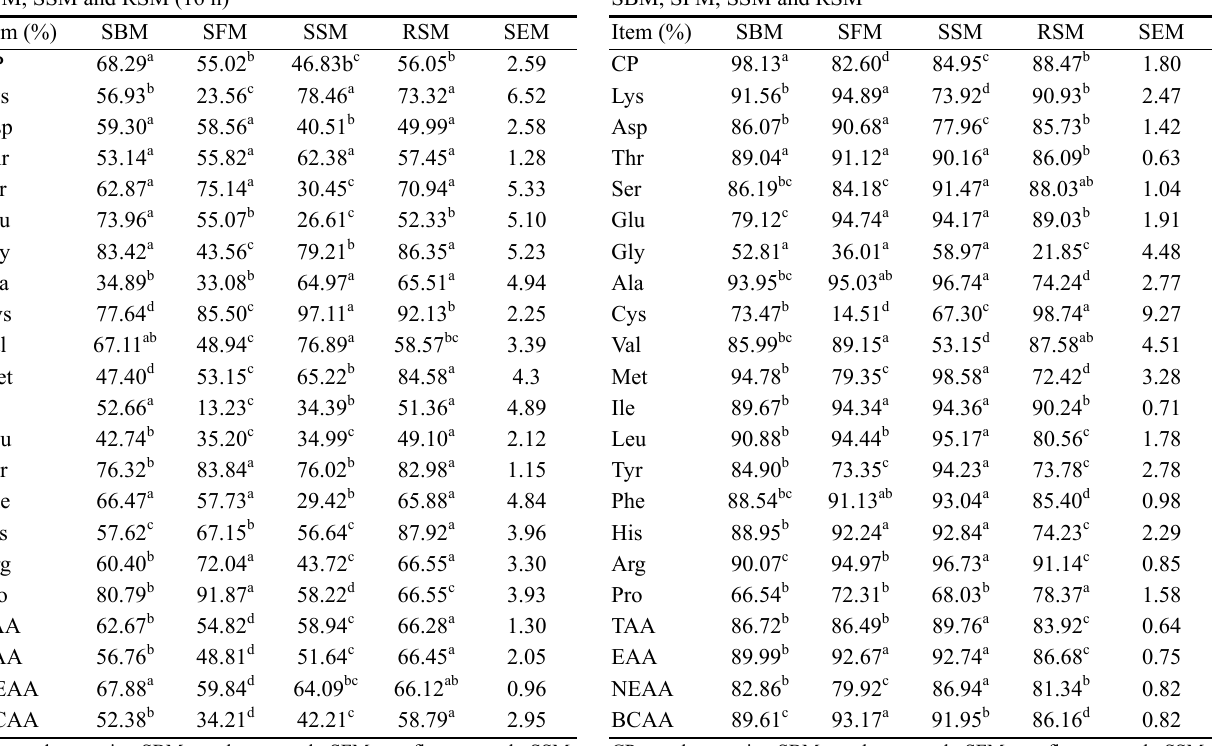
Table 6. Small intestinal digestibility of CP and amino acids